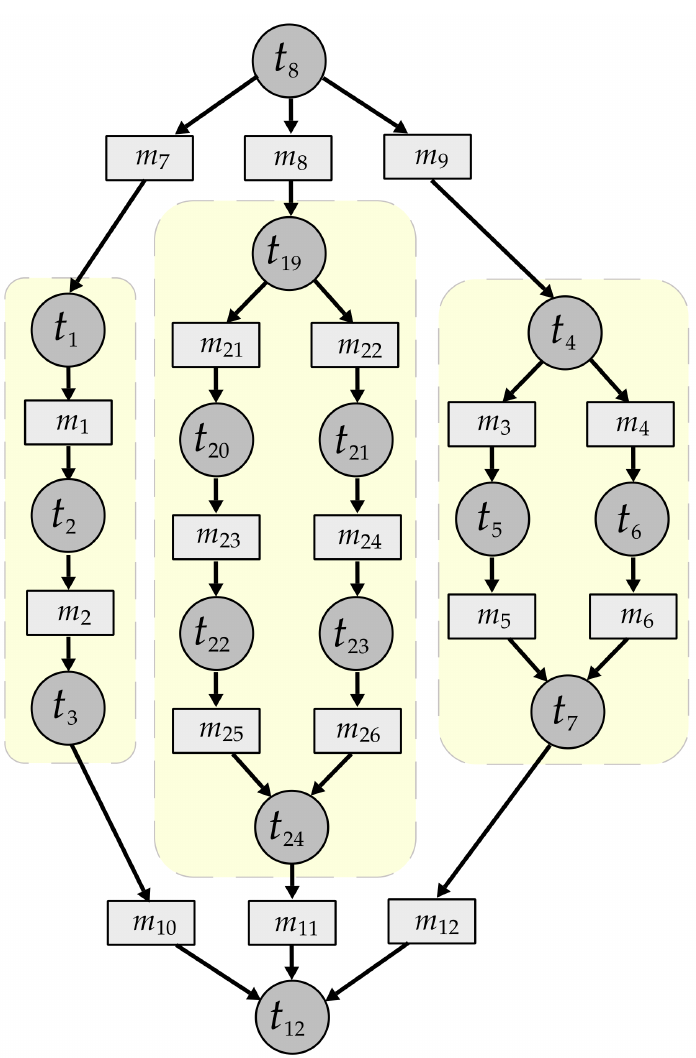
Figure 4. Example of a two terminal series-parallel (TTSP) application